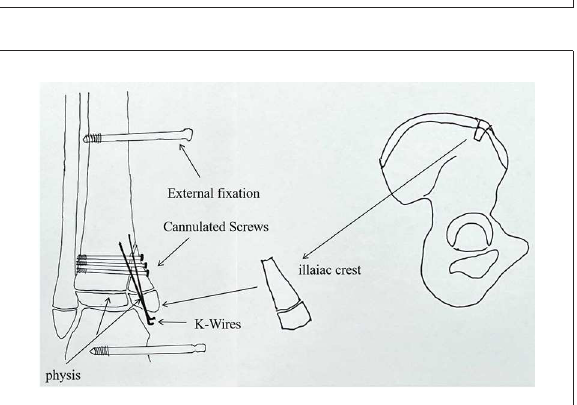
FIGURE2 An illustration of the surgical plan using an iliac crest apophyseal autograft. The graft is held together by screws and k-wires, and the ankle is held by the external